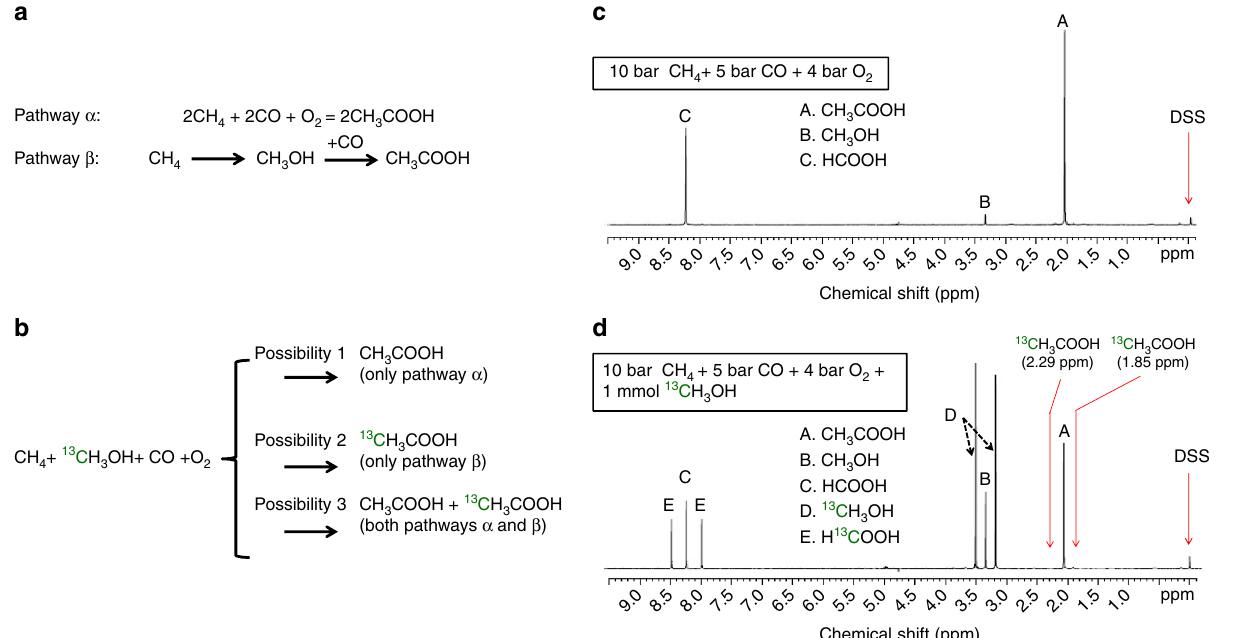
Fig. 5 Isotope studies for elucidating whether acetic acid could be formed through coupling methanol with CO. a Two potential pathways α and β for production of acetic acid; in pathway α , CH 3 OH is not an intermediate compound for formation of CH 3 COOH; in pathway β , CH 3 OH is an intermediate compound for formation of CH 3 COOH. b Potential catalytic products formed from 0.10 wt%Rh/ZSM-5 in the mixture of 13 CH 3 OH and H 2 O in solution under mixture of CH 4 , CO, and O 2 if the transformation of CH 4 , CO, and O 2 follows pathway α , β , or both α and β . c NMR spectra of the products formed from 28 mg of 0.10 wt%Rh/ZSM-5 after reaction in 10 bar CH 4 , 5 bar CO, and 4 bar O 2 at 150 °C for 1 h; there was no any isotope-labeled methanol, 13 CH 3 OH added to the rector before this catalysis test. d NMR spectra of the products formed from 28 mg of 0.10 wt%Rh/ZSM-5 after reaction in 10 bar CH 4 , 5 bar CO, and 4 bar O 2 at 150 °C for 1 h.; notably, 1.0 mmol 13 CH 3 OH was added to H 2 O before this catalysis in Supplementary Fig. 8 28 mg 0.10 wt%Rh/ZSM-5 in 10 mL n - dodecane in the mixture of 30 bar CH 4 , 10 bar CO, and 5 bar O 2 is de fi nitely active for the formation of acetic acid. The signi fi cant